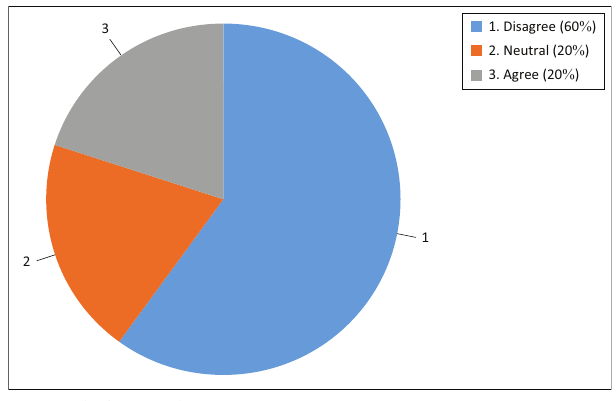
FIGURE 3: Students’ views on whether or not multilingualism is promoted in lectures: Multilingualism is promoted in the lecture setting of the courses you take ( % )